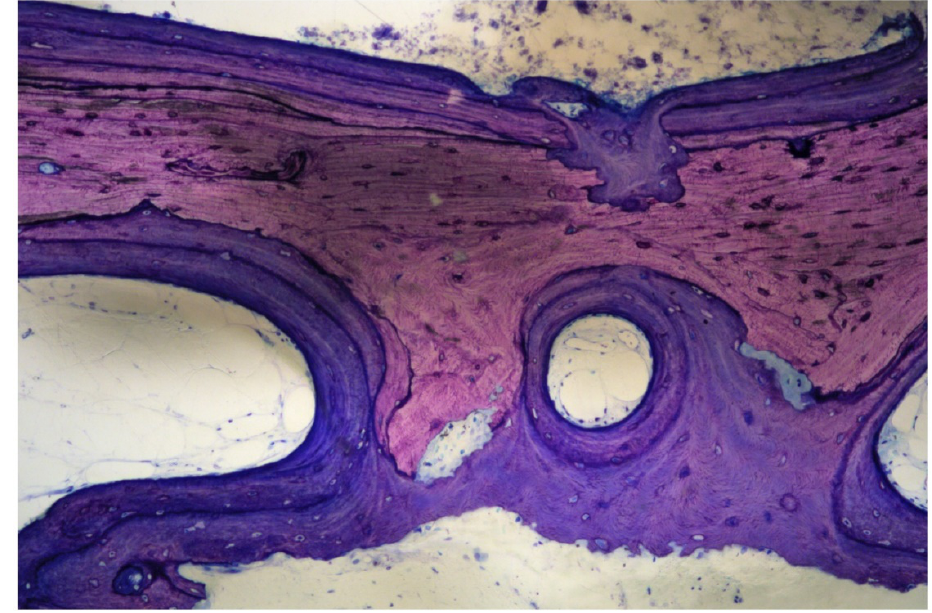
Figure 5. Biopsy of grafted Osteomycin TM , 6 months after removal of an infected dental implant and simultaneous implantation into the maxilla. “Creeping substitution” with osteoclasts resorbing the graft and osteoblasts depositing new bone simultaneously. There are no signs of inflammation.